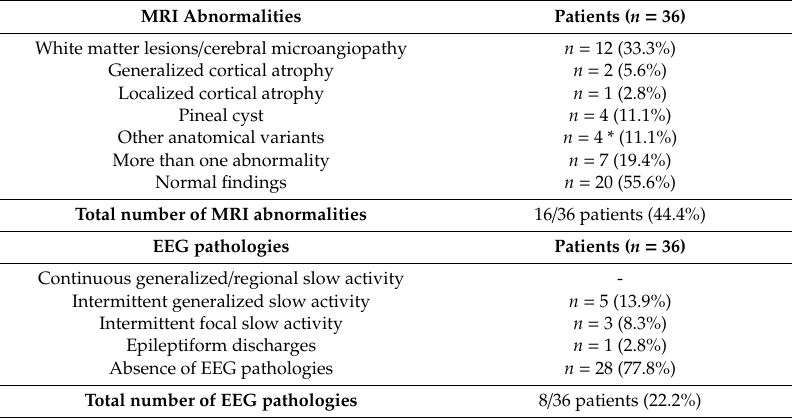
Table 6. MRI and EEG pathologies in the ASD patient